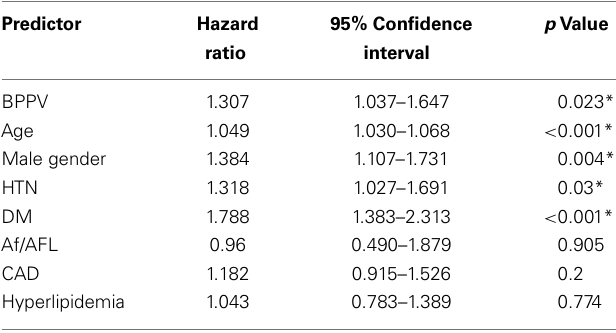
Table 4 | Predictors of ischemic stroke in individuals more than 65years old analyzed by Cox regression analysis